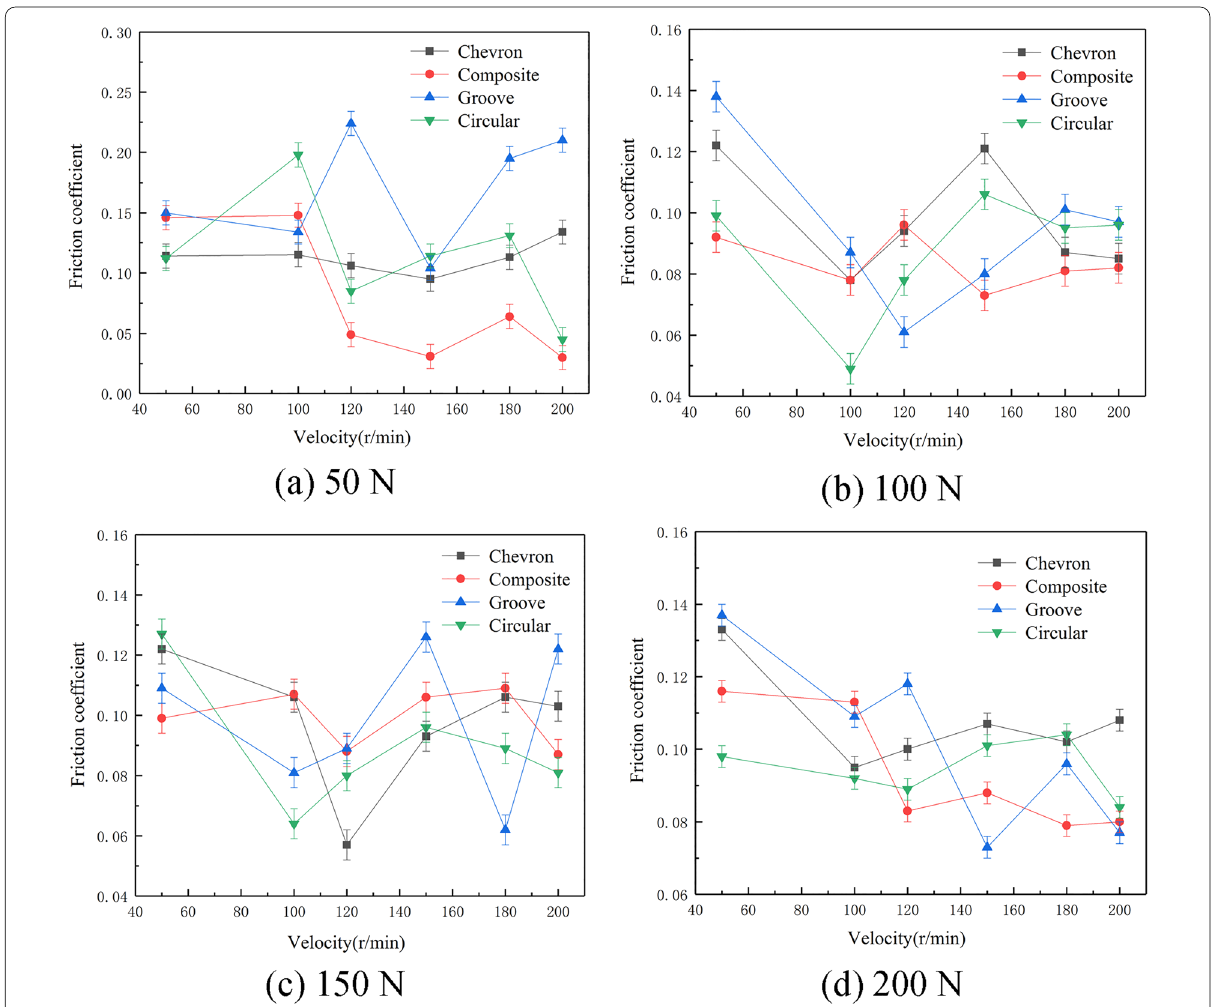
Figure 13 Variation curve of friction coefficient of different textures under the same loading